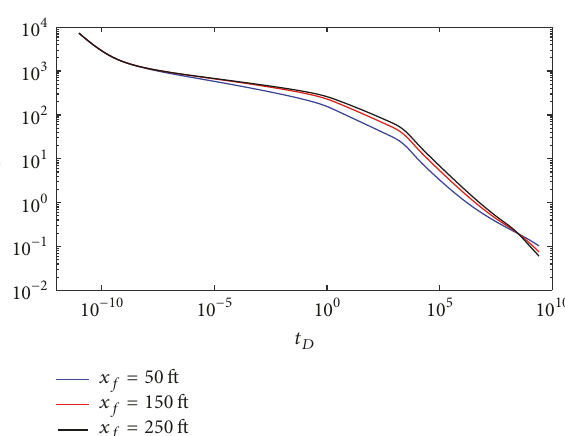
Figure 4: Effect of hydraulic fracture half-length on production.